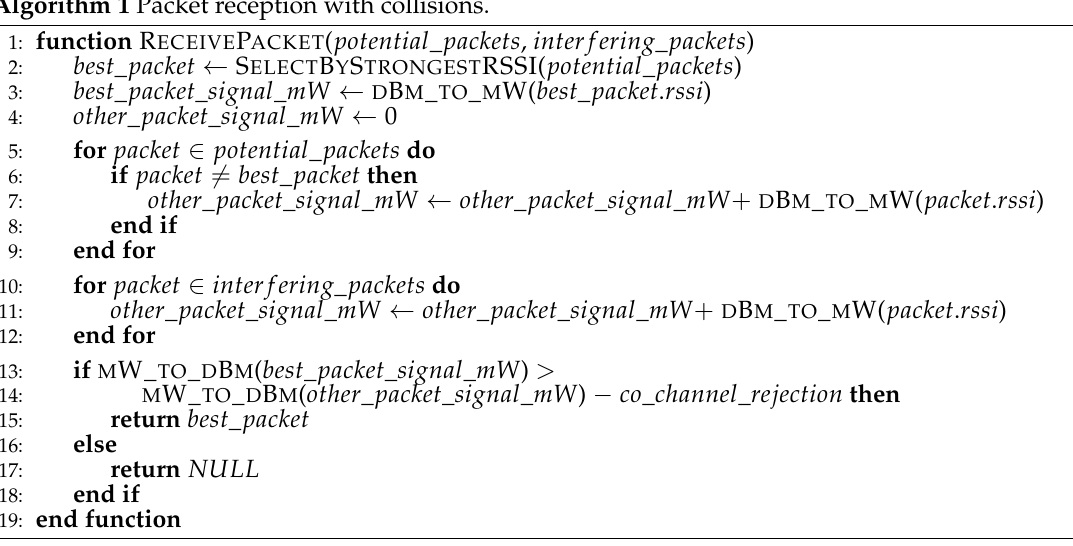
Algorithm 1 implements reception with the capture effect [18]. In the algorithm’s pseudo-code, functions D B M _ TO _ M W() and M W_ TO _ D B M () refer to conversion between RSSI, as commonly given in decibel-milliwatts, and transmission power in milliwatts. The goal is to determine whether any of the packets can still be received, which is the case if the strongest RSSI is more than the sum of the other RSSI minus the hardware-specific co-channel rejection threshold (by default − 3 dBm in TSCH-Sim). Algorithm 1 Packet reception with